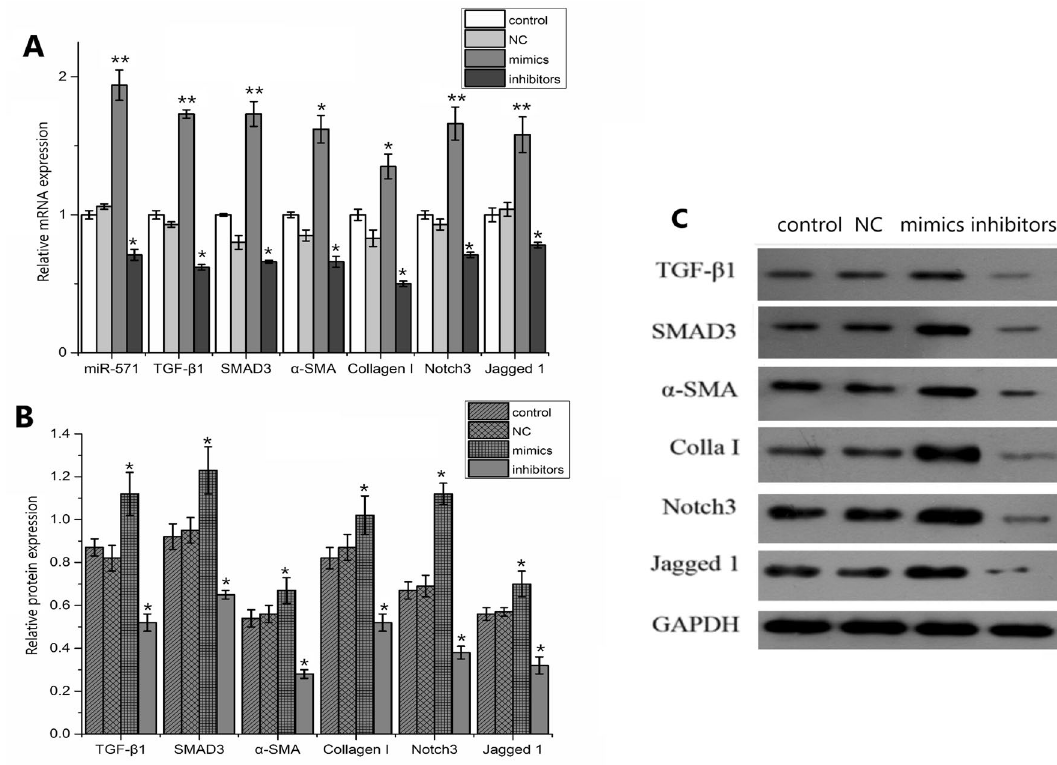
Figure 6. Effects of miR-571 on Notch3 signaling pathway and expression of fibrogenic factors. ( A ) Effects of miR-571 on Notch3 signaling pathway and expression of fibroblast mRNA; ( B , C ) effects of miR-571 on Notch3 signaling pathway and the expression of fibroblast protein. Experimental groups (transfected with miR-571 mimics); negative control groups (transfected with negative control mimics); inhibitor groups (transfected with miR-571 inhibitor mimics); blank control groups were set up. Up regulation of miR-571 promotes the expression of Notch3 signaling pathway and fibrogenic factor mRNA and protein. * P < 0.05, ** P <